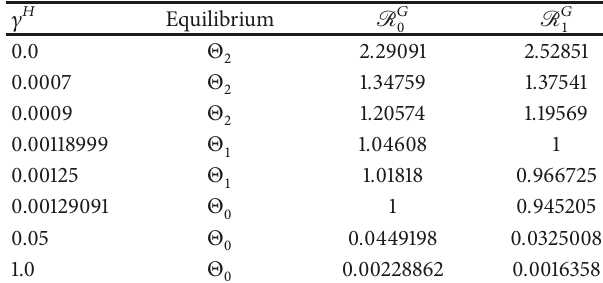
Table 1: The values of R 𝐺 0 and R 𝐺 1 for system (69)-(73) with differ- ent values of 𝛾 𝐻